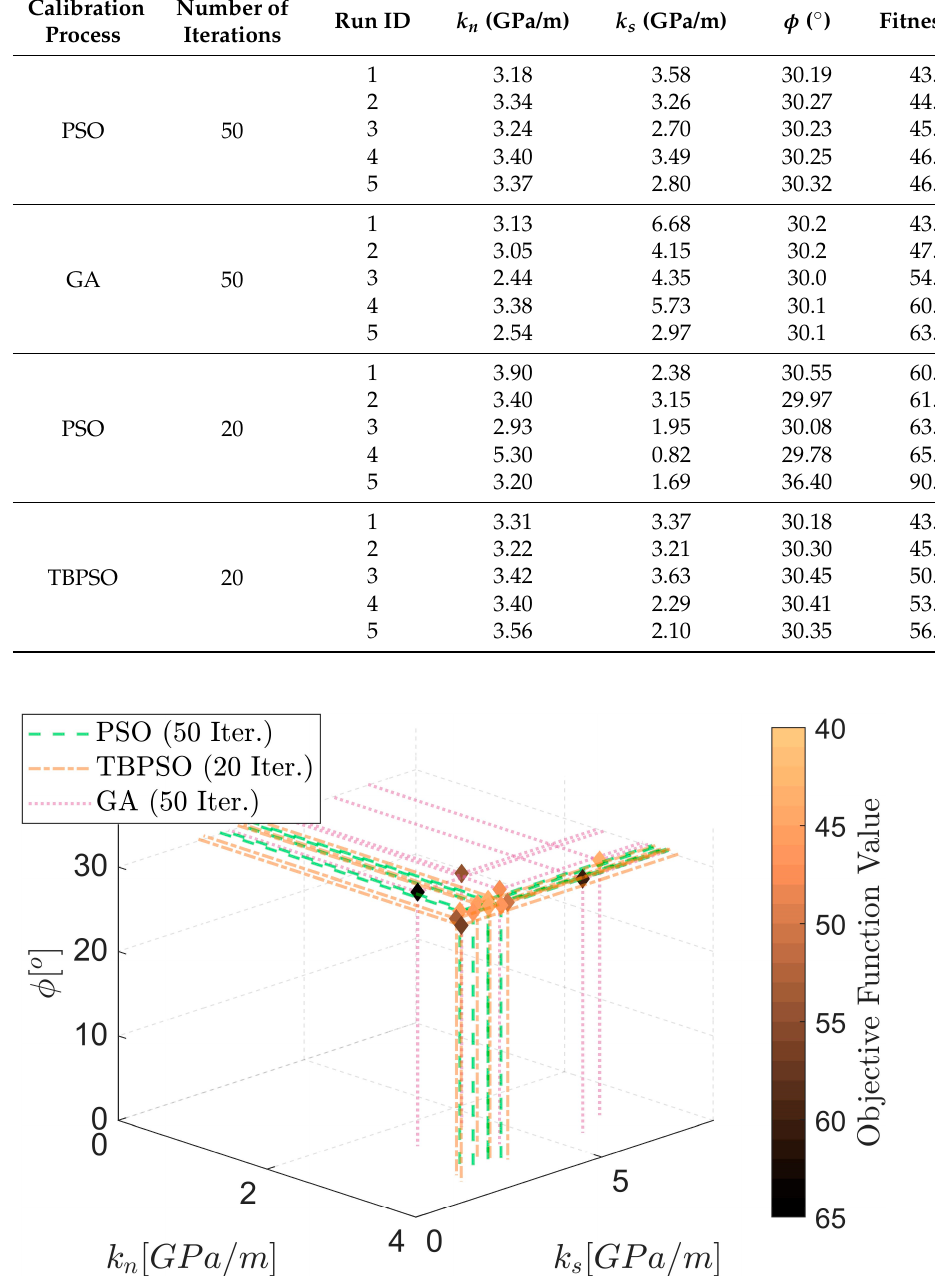
Table 2. Five best solution sets for objective function 2 of Pulatsu’s geometry.